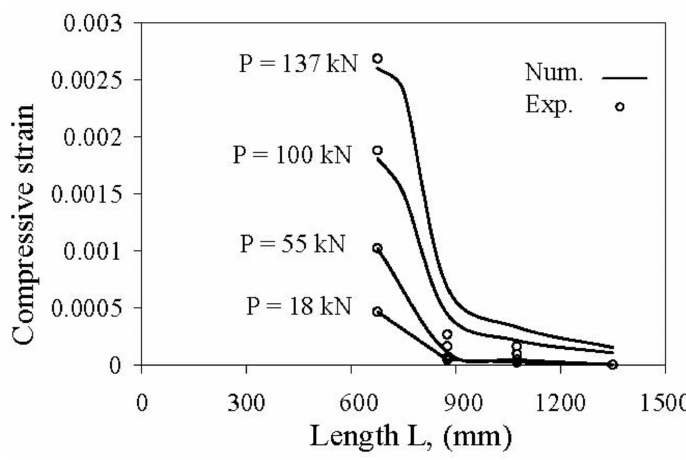
Figure 14. Compressive concrete strains curve along the beam span for beam